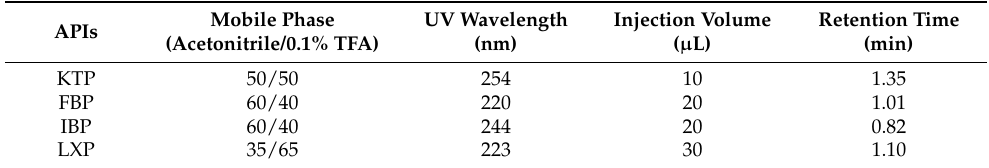
Table 3. HPLC analytical conditions for each APIs.